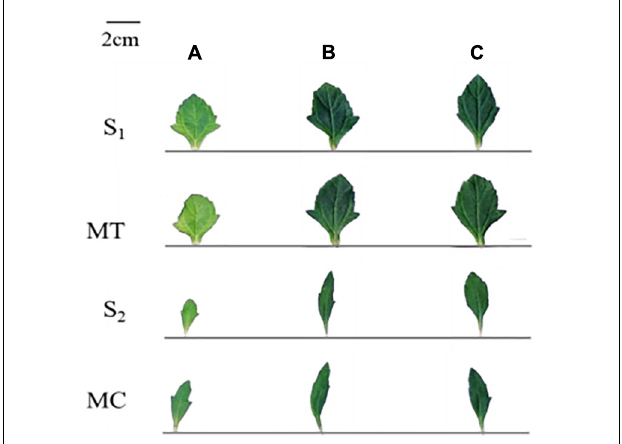
FIGURE 3 | Leaf morphology of invasive W. trilobata and native W. chinensis under different N forms and competition period. AA, ammonium nitrogen; NN, nitrate nitrogen; S 1 , intraspecific competition of W. trilobata ; S 2 , intraspecific competition of W. chinensis ; MT, interspecific competition of W. trilobata ; MC, interspecific competition of W. chinensis ; (A) no nitrogen addition; (B) nitrogen form ratio AN:NN, 2:1 with total nitrogen amount of 15 g N · m − 2 · year − 1 ; (C) nitrogen form ratio AN:NN, 1:2 with total nitrogen amount of 15 g N · m − 2 · year − 1